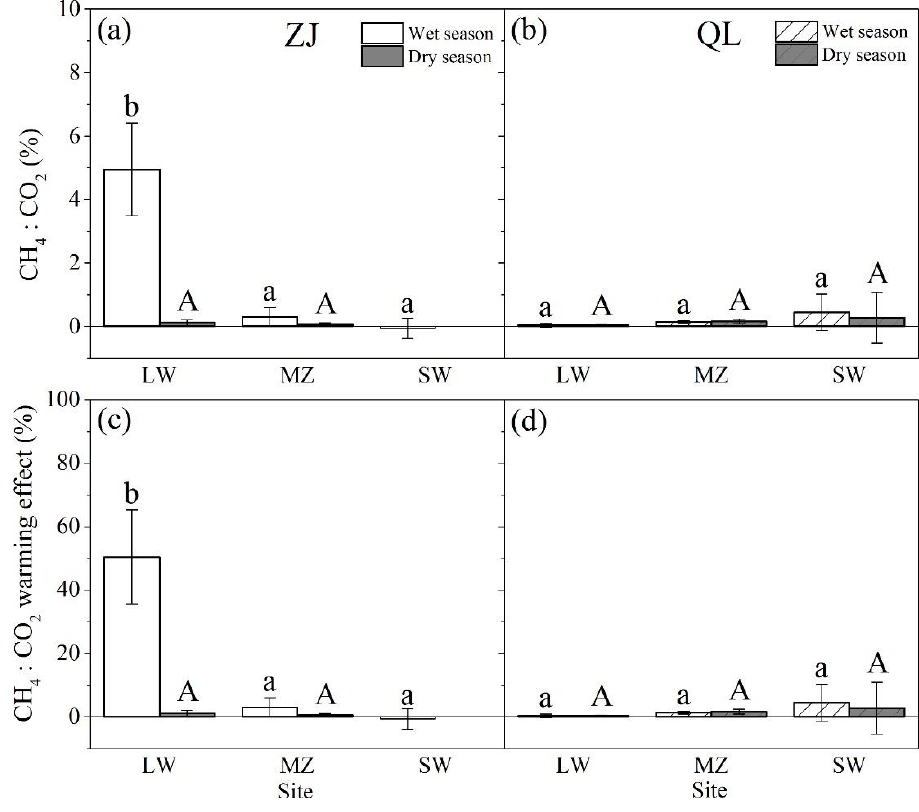
and assignment of eutrophic